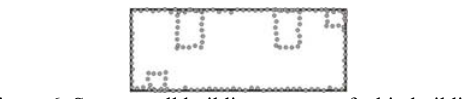
Figure 6. Some small buildings on top of a big building.